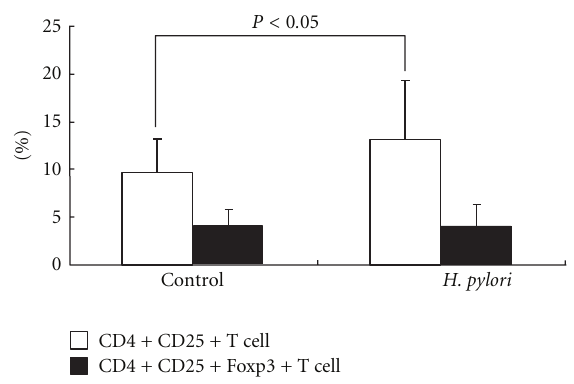
Figure 3: The percentage of CD4 + CD25 + T cell and CD4 + CD25 + Foxp3 + (regulatory T cell). Left and right sides show the data of control subjects and H. pylori- infected patients, respectively. White columns represent the percentage of CD4 + CD25 + T cell, and black columns represent the percentage of regulatory T cell. Data are given as mean ± SD. The percentage of CD4 + CD25 + T cells in H. pylori- infected patients (mean ± SD; 13 . 2 ± 6 . 2%) was significantly higher than that in control subjects (mean ± SD; 9 . 8 ± 3 . 4%) ( P < 0 . 05). The percentage of Tregs (CD4 + CD25 + Foxp3 + T cells) was not significantly di ff erent between H. pylori -infected patients (mean ± SD; 4 . 1 ± 2 . 1%) and control subjects (mean ± SD; 4 . 0 ± 1 . 7%).